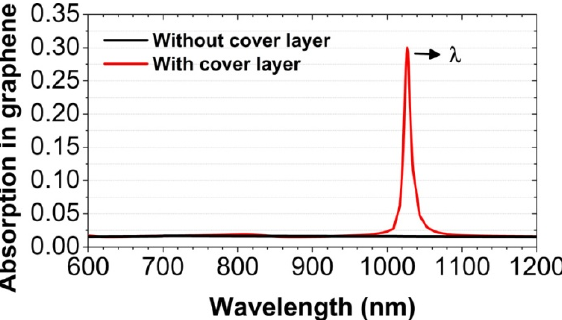
Figure 2. The numerically calculated absorption spectra of the graphene monolayer at normal incidence. Geometrical parameters: The array periods p x = 400 nm and p y = 700 nm; the diameter of the Au nanospheres d = 150 nm; the thickness of the SiO 2 cover layer t = 500 nm.